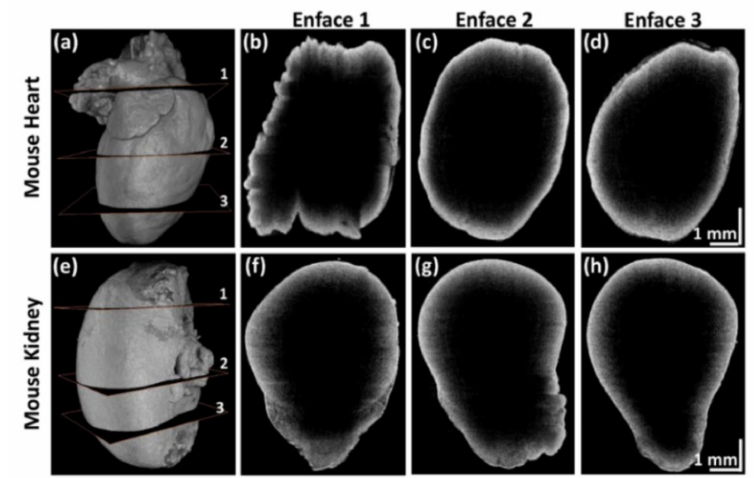
Figure 8. 3D volumetric and representative enface images of mouse heart and kidney using quad- scanner (QS)-OCT. ( a , e ) are full-directional 3D rendering morphological images of a mouse heart and kidney; ( b – d ) and ( f – h ) are the selected enface images obtained at the three different layers shown in ( a , e ),